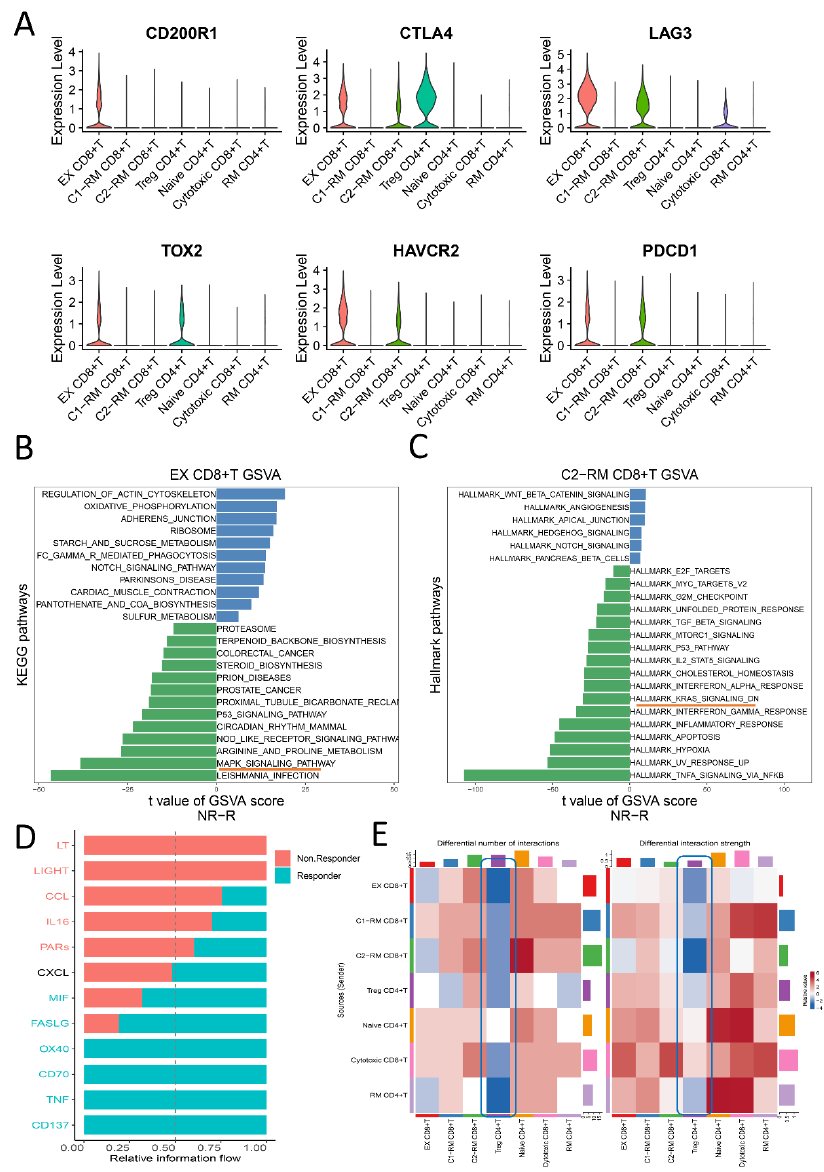
Figure 2. Differences in molecular pathways and cellular communication between the responder and non-responder groups. ( A ): Violin diagram displays the distribution of six immune checkpoint genes ( PDCD1, TIM3/HAVCR2, TOX2, LAG3, CD200R1 ) in seven types of T cell subsets. Different colors indicate different cell populations. ( B , C ): Analysis of gene set variation of EX CD8 + T cells and C1-RM CD8 + T cell subsets in the responder and non-responder groups, the differential KEGG pathways and hallmark pathways between them were sorted according to the t value of statistical results. The orange underline indicates that the MAPK signaling pathway was enriched in the non- responsive group, while KRAS signaling was concentrated in the non-responsive group. The blue bar indicates the responder while the green denotes the non-responder. ( D ): Bar graph illustrating the relative information flow of the signaling pathway between the responder and non-responder groups, blue indicates that the corresponding pathway is highly enriched in respondents, and vice versa. ( E ): Heatmap showing the difference in the number and strength of cell interactions. The blue rectangle indicates that, contrary to the response group, more and stronger cellular connections were observed between Treg CD4 + T cells and other cell subsets. The darker the blue color, the greater the strength and number of cell interactions in the non-responsive